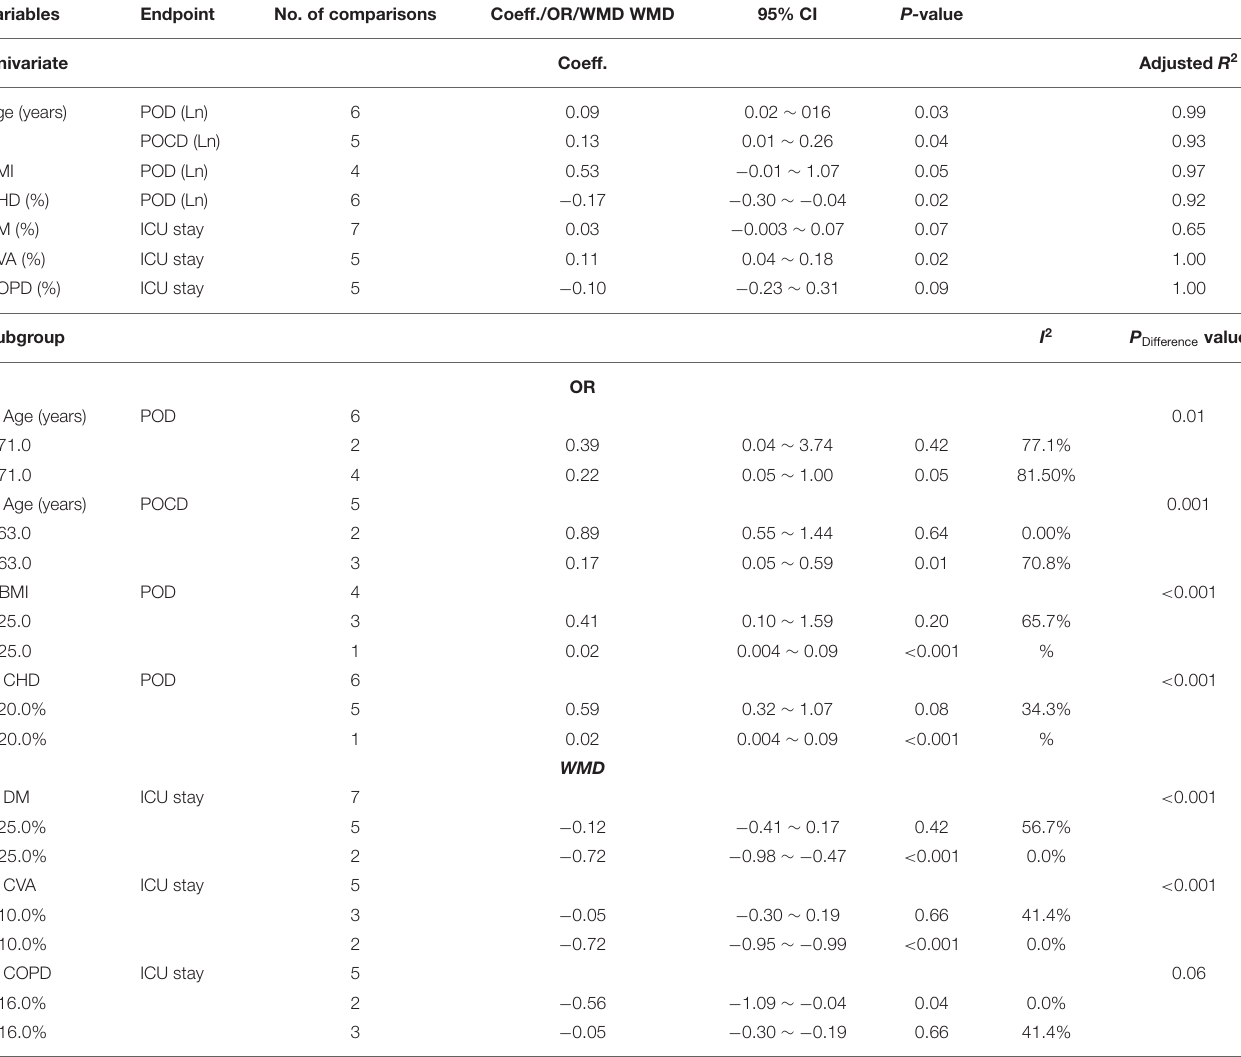
TABLE 3 | Meta-regression and subgroup analyses for the potential sources of heterogeneity. Variables Endpoint No. of comparisons Coeff./OR/WMD WMD 95% CI P- value Univariate Coeff. Adjusted R